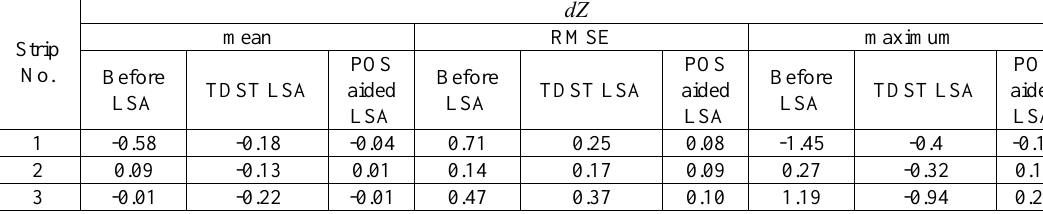
Table 3. The vertical coordinate residuals of vertical check point before and after LSA (units ：